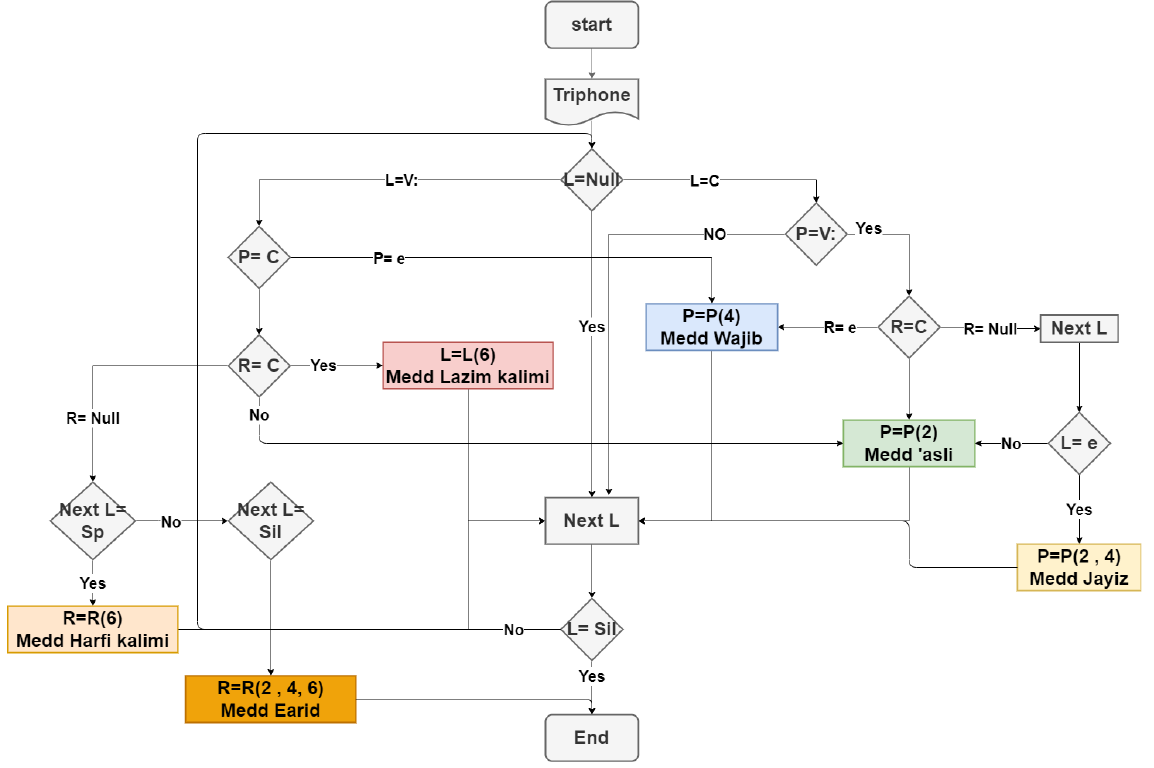
Figure 13. Identify Medd type using RPDAMC.